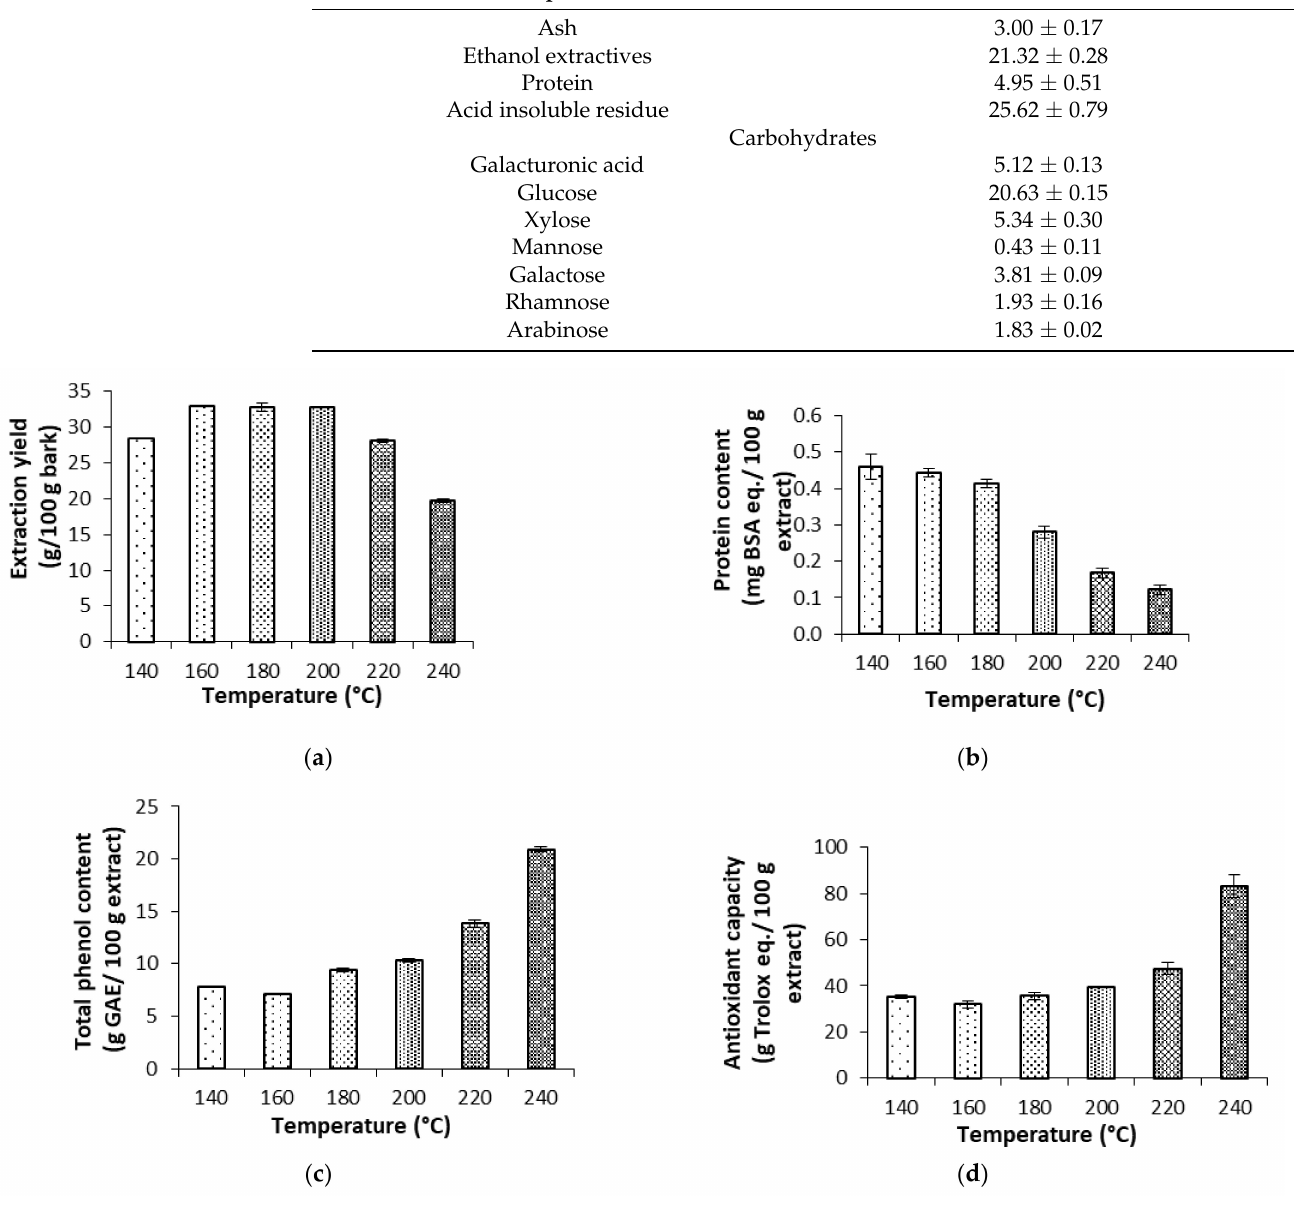
Table 1. Composition of Paulownia elongata x fortunei bark.